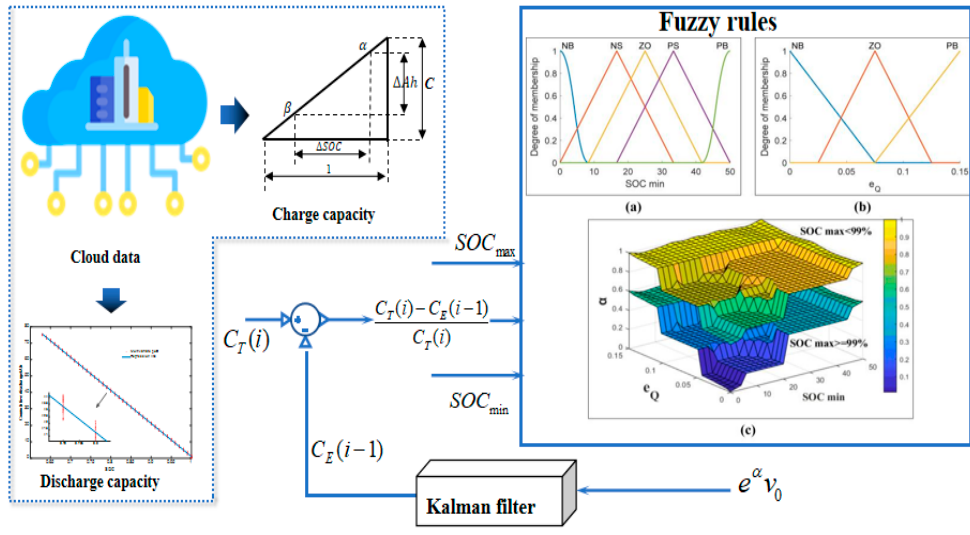
Figure 5. FL + KF flow chart.